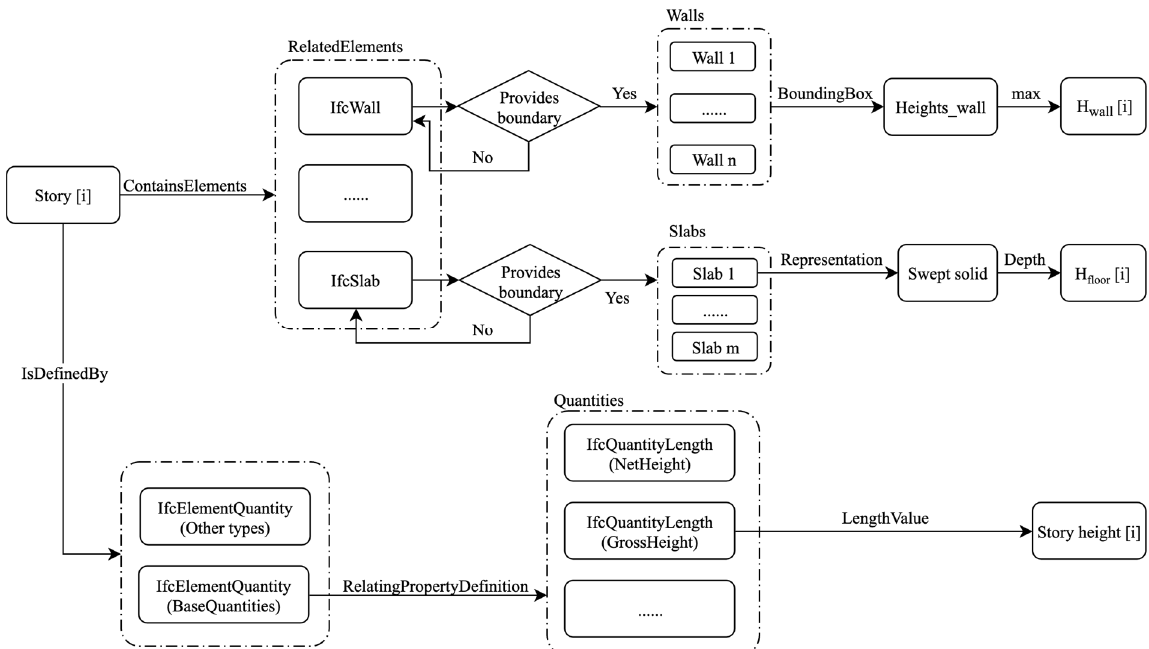
Figure 9. Acquiring building story height using two methods.